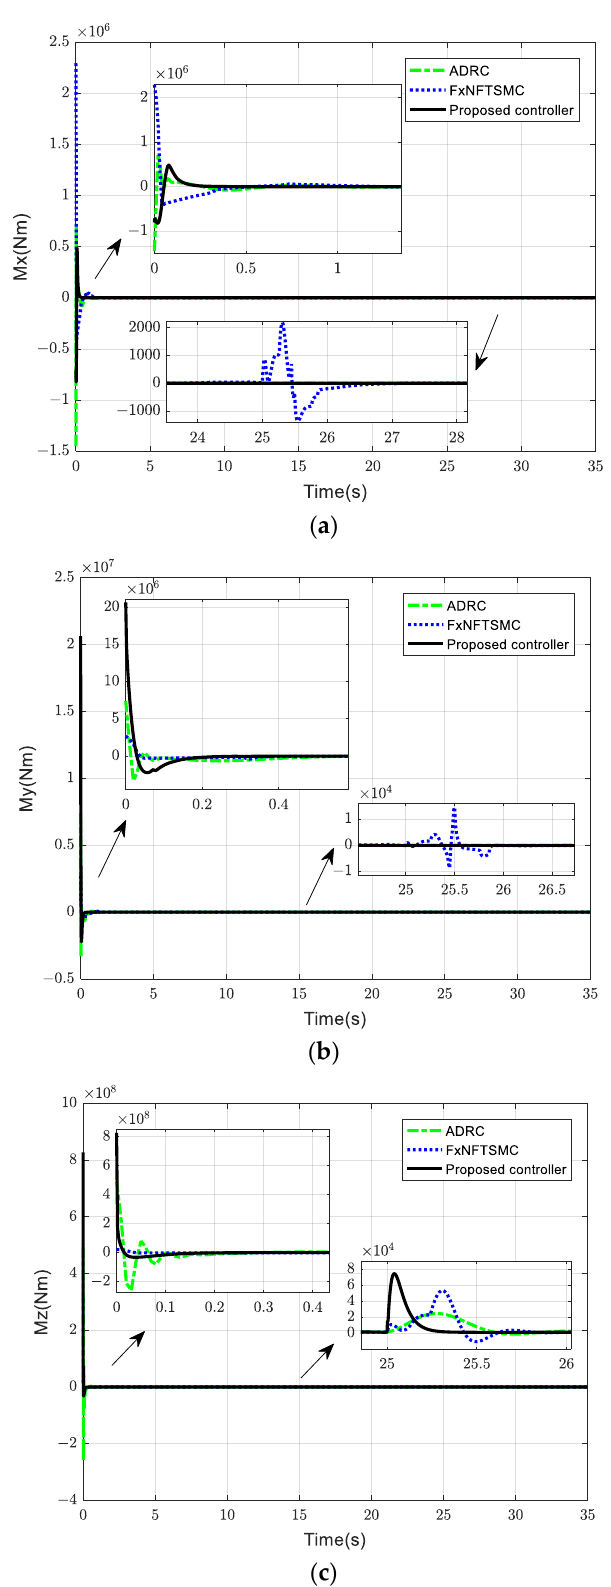
Figure 8. Control moment of three channels: ( a ) the roll channel; ( b ) the yaw channel; ( c ) the pitch channel.